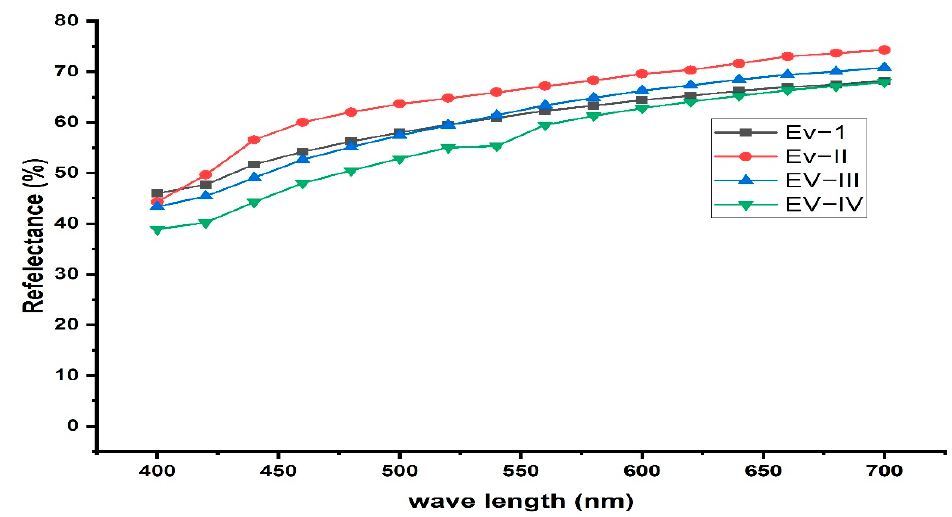
Figure 9. CIE Lab values of fiber portions along the length.